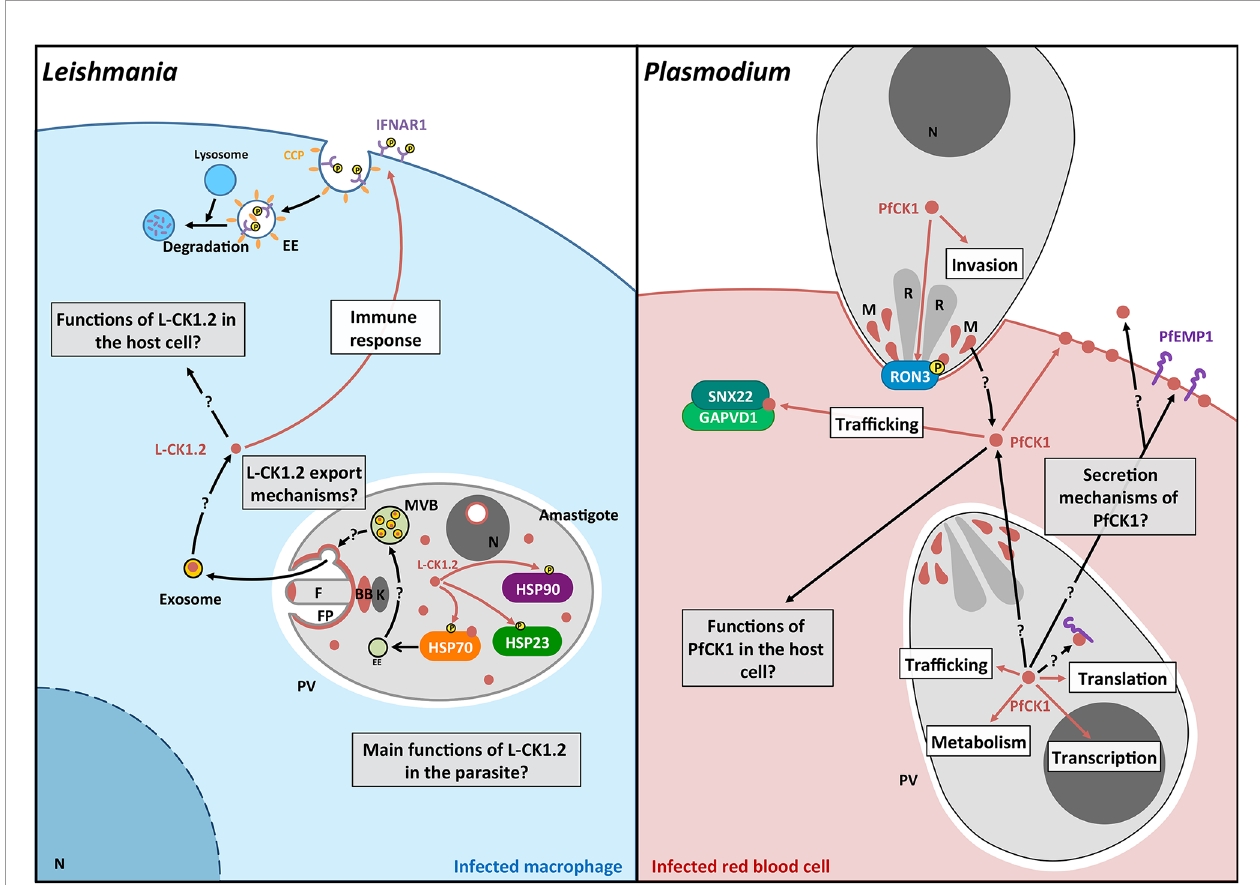
FIGURE 3 | Schematic representation of the pathways regulated by L-CK1.2 and PfCK1. Left panel. L-CK1.2 is localised in the parasite at the fl agellar tip, the fl agellar pocket, the basal body, the nucleolus and the cytoplasm as shown in brown. It phosphorylates three heat shock proteins as symbolized by brown arrows. L-CK1.2 has been identi fi ed in exosomes although the mechanisms leading to its loading into exosomes and its release are currently unknown. L-CK1.2 has functions in the macrophage, particularly in innate immunity (white box), however, most of its functions remain to be identi fi ed (grey box). Right panel. PfCK1 seems to be important for invasion either through phosphorylation of Ron3 or release by micronemes. In the parasite, PfCK1 seems to be involved in functions such as translation or traf fi cking (white box) but the speci fi c mechanisms need to be elucidated. PfCK1 seems to be also released in red blood cells (RBC) as well as in the extracellular environment by unknown mechanisms. One function of PfCK1 in RBCs could be related to the regulation of traf fi cking through the binding of two host proteins. White boxes correspond to potential functions; Grey boxes correspond to key questions; Brown arrows correspond to known mechanisms. Black arrows correspond to mechanisms that need to be identi fi ed. F, Flagellum; FP, Flagellar pocket; BB, Basal body; k, kinetoplast; EE, Early endosome; MVB, Multivesicular bodies; N, Nucleus; CCP, Clathrin coated pit; P, phosphorylation; R, Rhoptry; M,